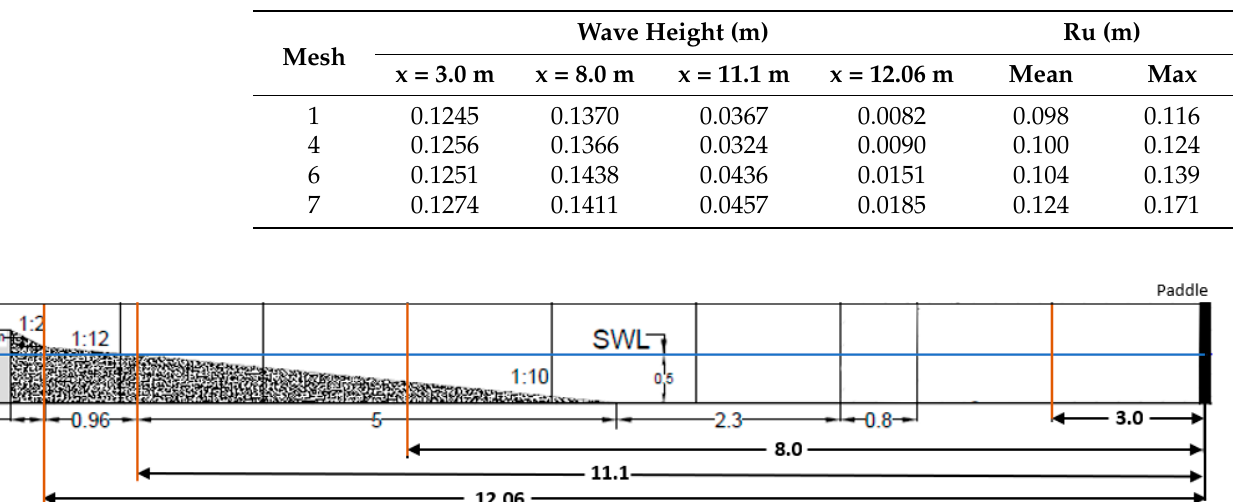
Table 4. Run-up case: mean wave height at gauges located at x = 3.0, 8.0, 11.1, and 12.06 m and mean and maximum run-up obtained in FLUENT.